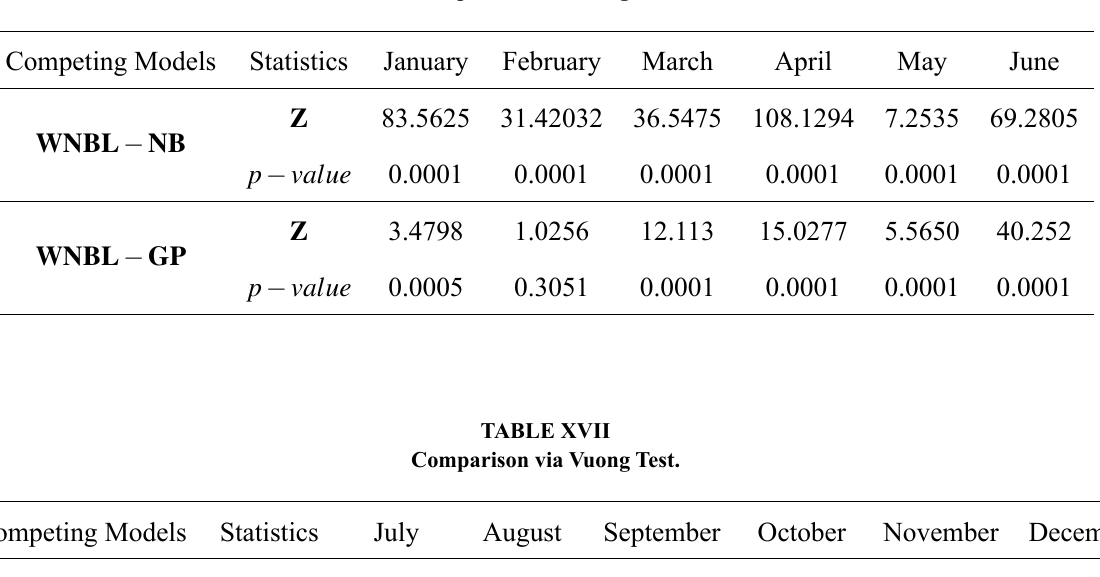
Comparison via Vuong Test.